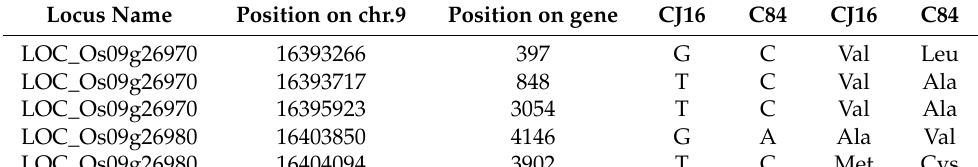
Table 4. Annotated genes included in the 16.17kb region for qLL9 .